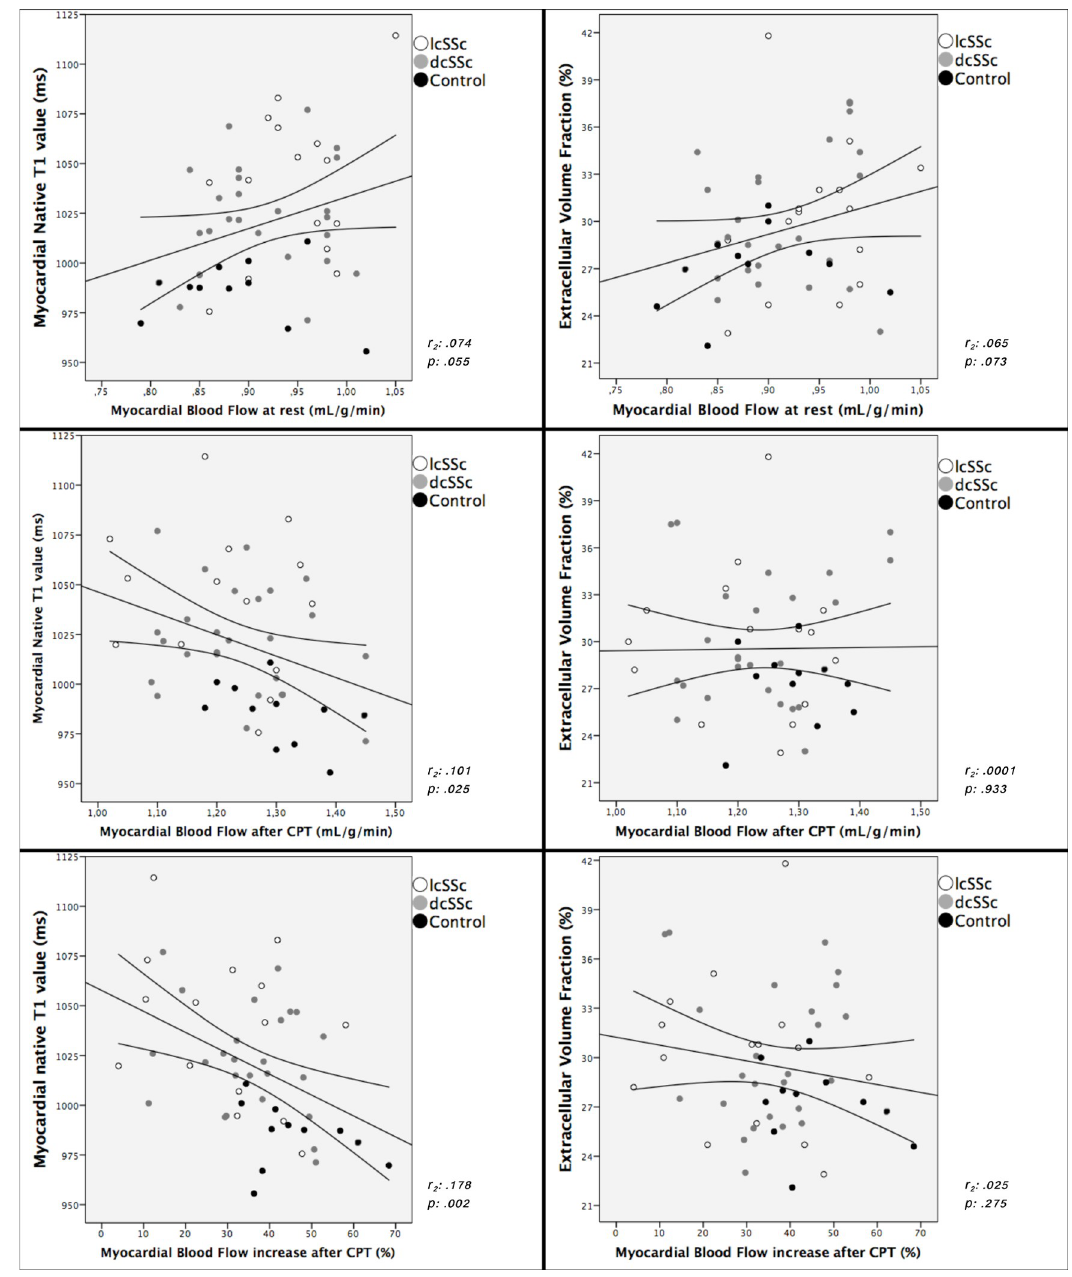
Fig 5. Myocardial nT1 and ECV plotted against MBF at rest, after cold pressor test (CPT) and %MBF variation after CPT.